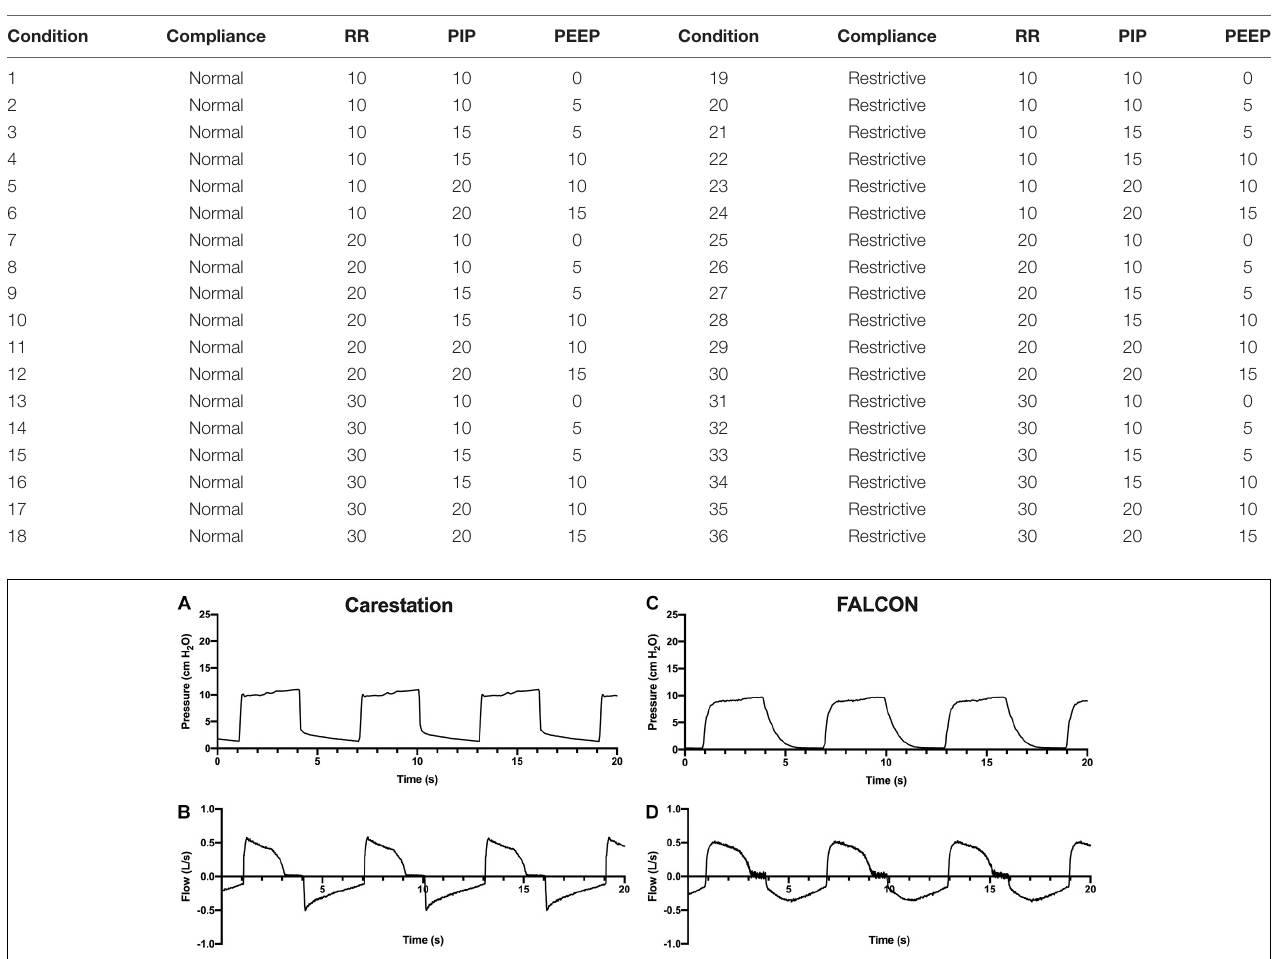
TABLE 1 | Conditions used in benchtop testing (RR = respiratory rate, in breaths per min; PIP = peak inspiratory pressure, in cm H 2 O; PEEP = positive end expiratory pressure, in cm H 2 O; normal lung compliance = 74 mL/cm H 2 O; restrictive lung compliance = 34 mL/cm H 2 O).